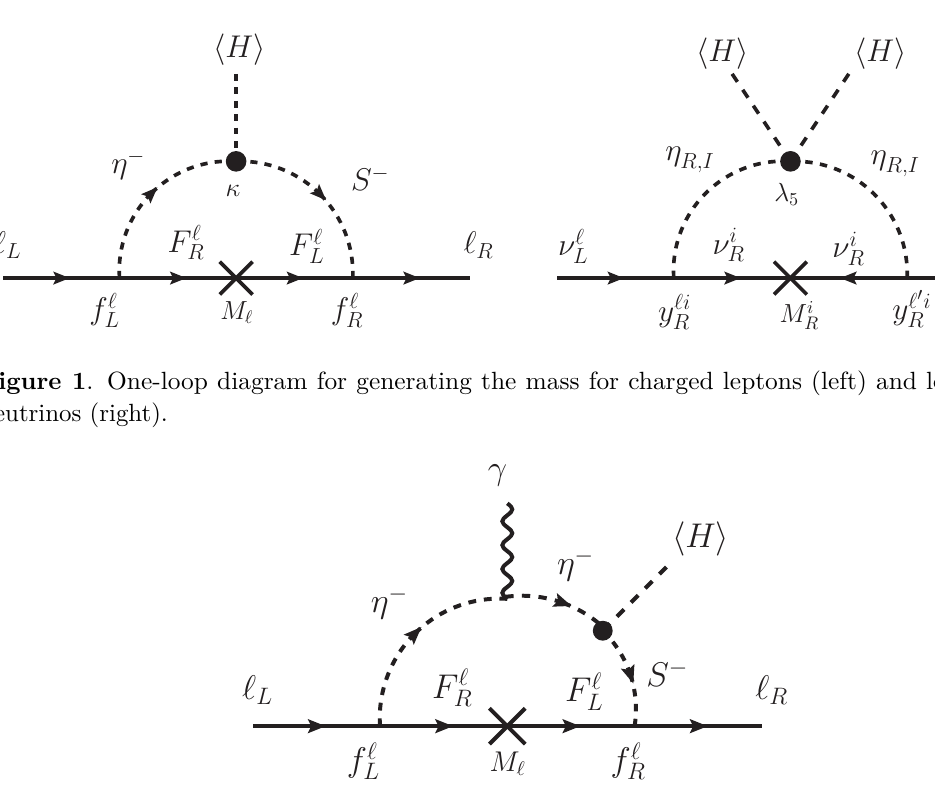
Figure 2 . Dominant new contributions to ( g − 2) for charged